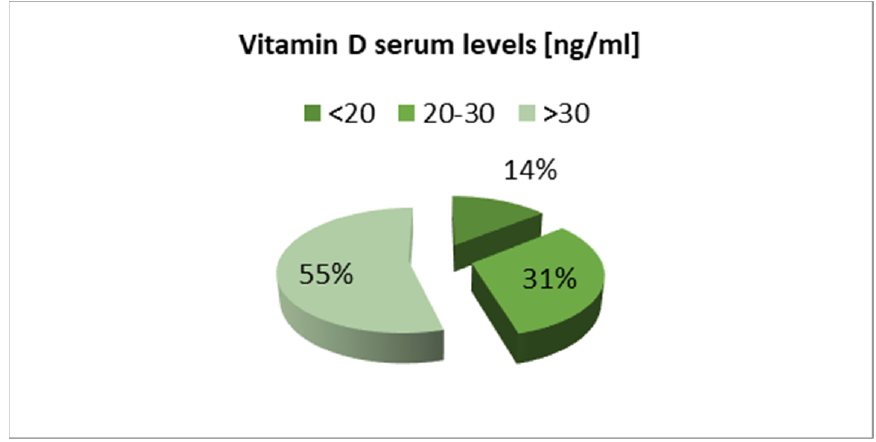
Figure 2. Vitamin D serum levels in children before the COVID-19 pandemic (Group 1).